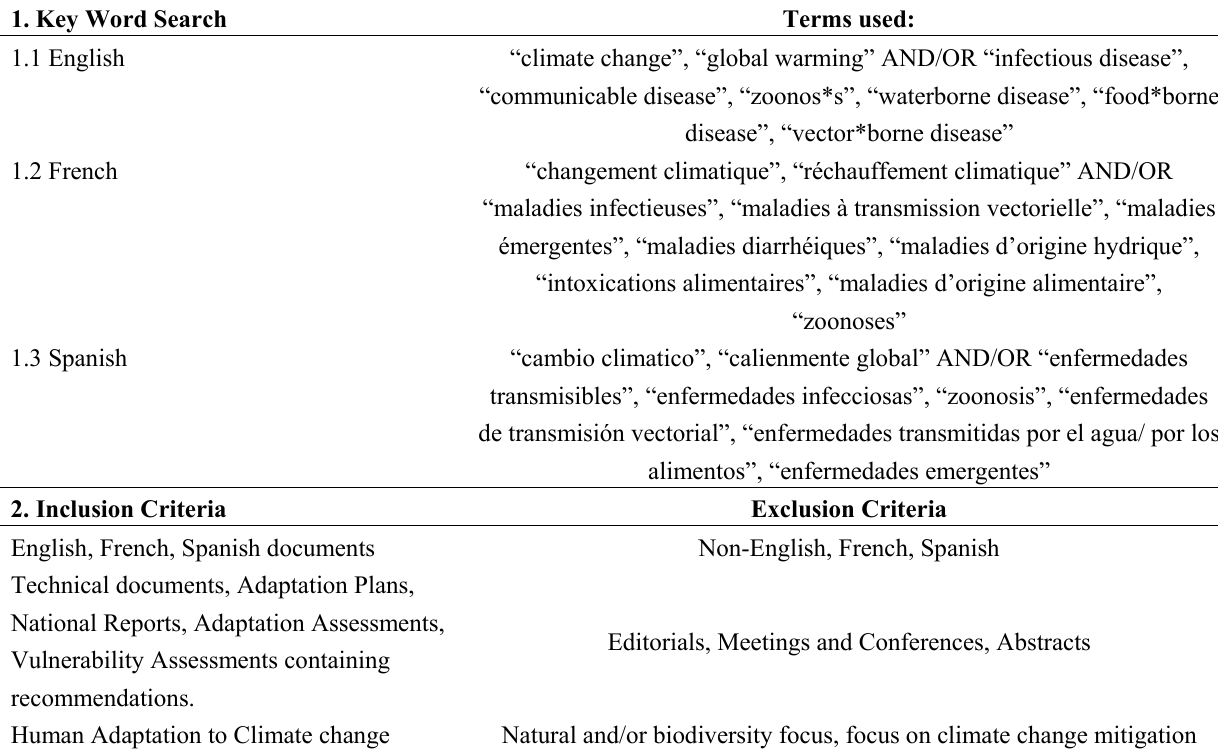
Table 2. Key words, inclusion and exclusion criteria for grey literature document retrieval and